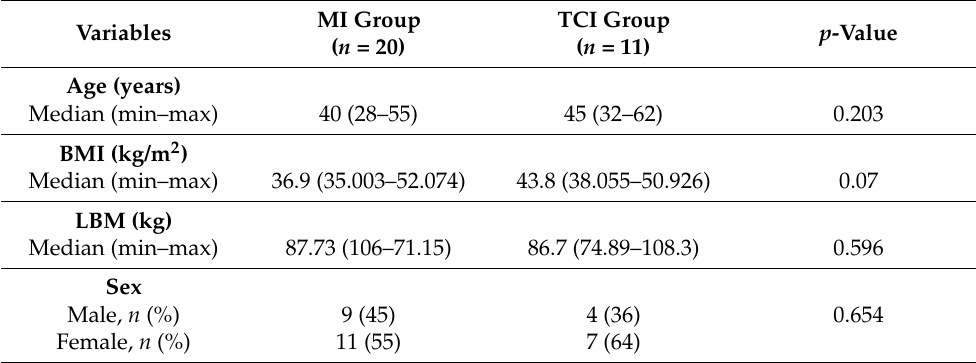
Table 1. Characteristics of study population.